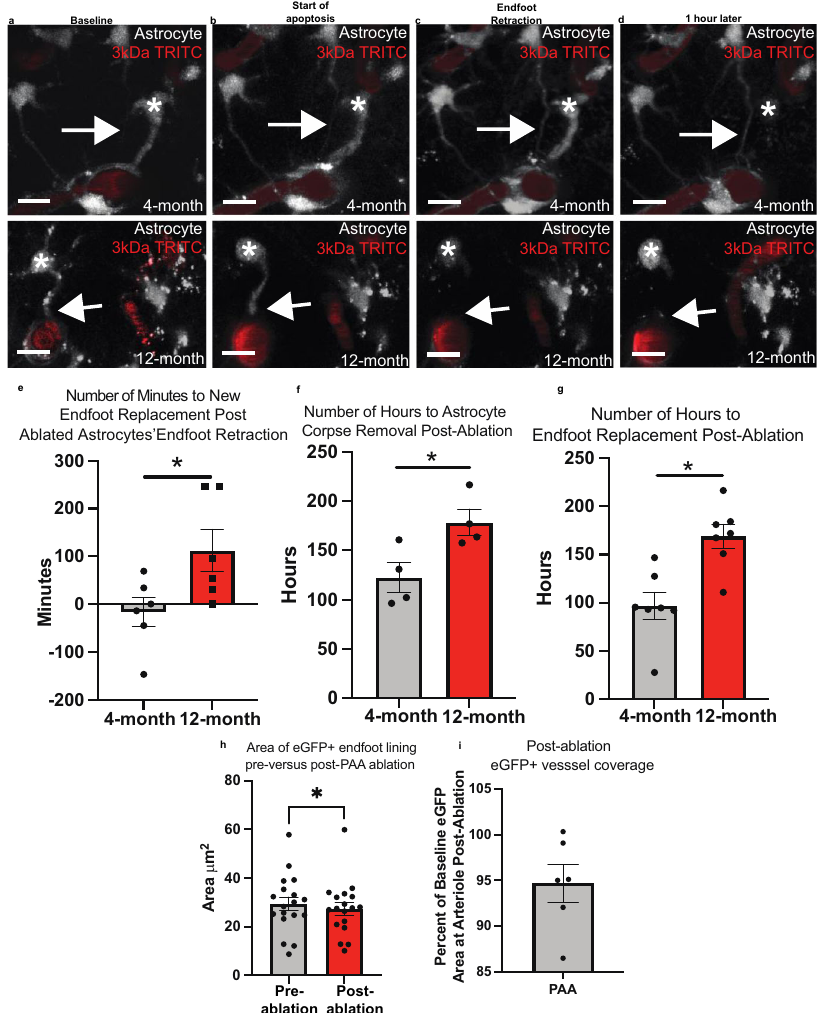
Fig. 4 Aging signi fi cantly attenuates the kinetics of the gliovascular structural plasticity response. In order to determine if the kinetics of endfoot replacement signi fi cantly slowed as a result of aging, we ablated astrocytes at penetrating arterioles and acquired continual z-stacks to capture the exact time of endfoot replacement. White asterisks indicate ablated astrocytes (shown in gray, blood vessels are in red) and arrows demarcate replacement processes (as in a and b ) or lack thereof (as in c and d ). Volumetric reconstruction showing a penetrating arteriole in a 4-month-old mouse (top) and 12- month old mouse (bottom) at a baseline, b the start of apoptosis, c the moment of endfoot retraction, and d one hour later. Scale bar = 10 µ m. n = 6 astrocytes across 4 mice. e Average number of minutes to new endfoot replacement post-ablation in 4- versus 12-month old mice. Two-tailed, unpaired t- test, p < 0.0371. f Average number of hours to astrocyte corpse removal post-ablation in 4- versus 12-month old mice. Two-tailed, unpaired t-test, p < 0.03. g Average number of hours to endfoot replacement in 4- versus 12-month-old mice post-ablation. Two-tailed, unpaired t-test, p < 0.0022. n = 6 cells across 4 mice for both age groups. h Average area of eGFP + endfoot lining around arterioles at ablated location pre- versus post-ablation. Two-tailed paired end t-test, p < 0.0370, n = 18 optical sections/4 mice. i Average post-ablation eGFP + endfoot vessel lining area expressed as a percentage of baseline. n = Focal PAA ablations at 6 arterioles/4 mice. Note that the data points in h are averaged to give one dot in ( i ). Data are presented as mean values ± SEM. LUTS have been adjusted to emphasize the replacement astrocytes and associated